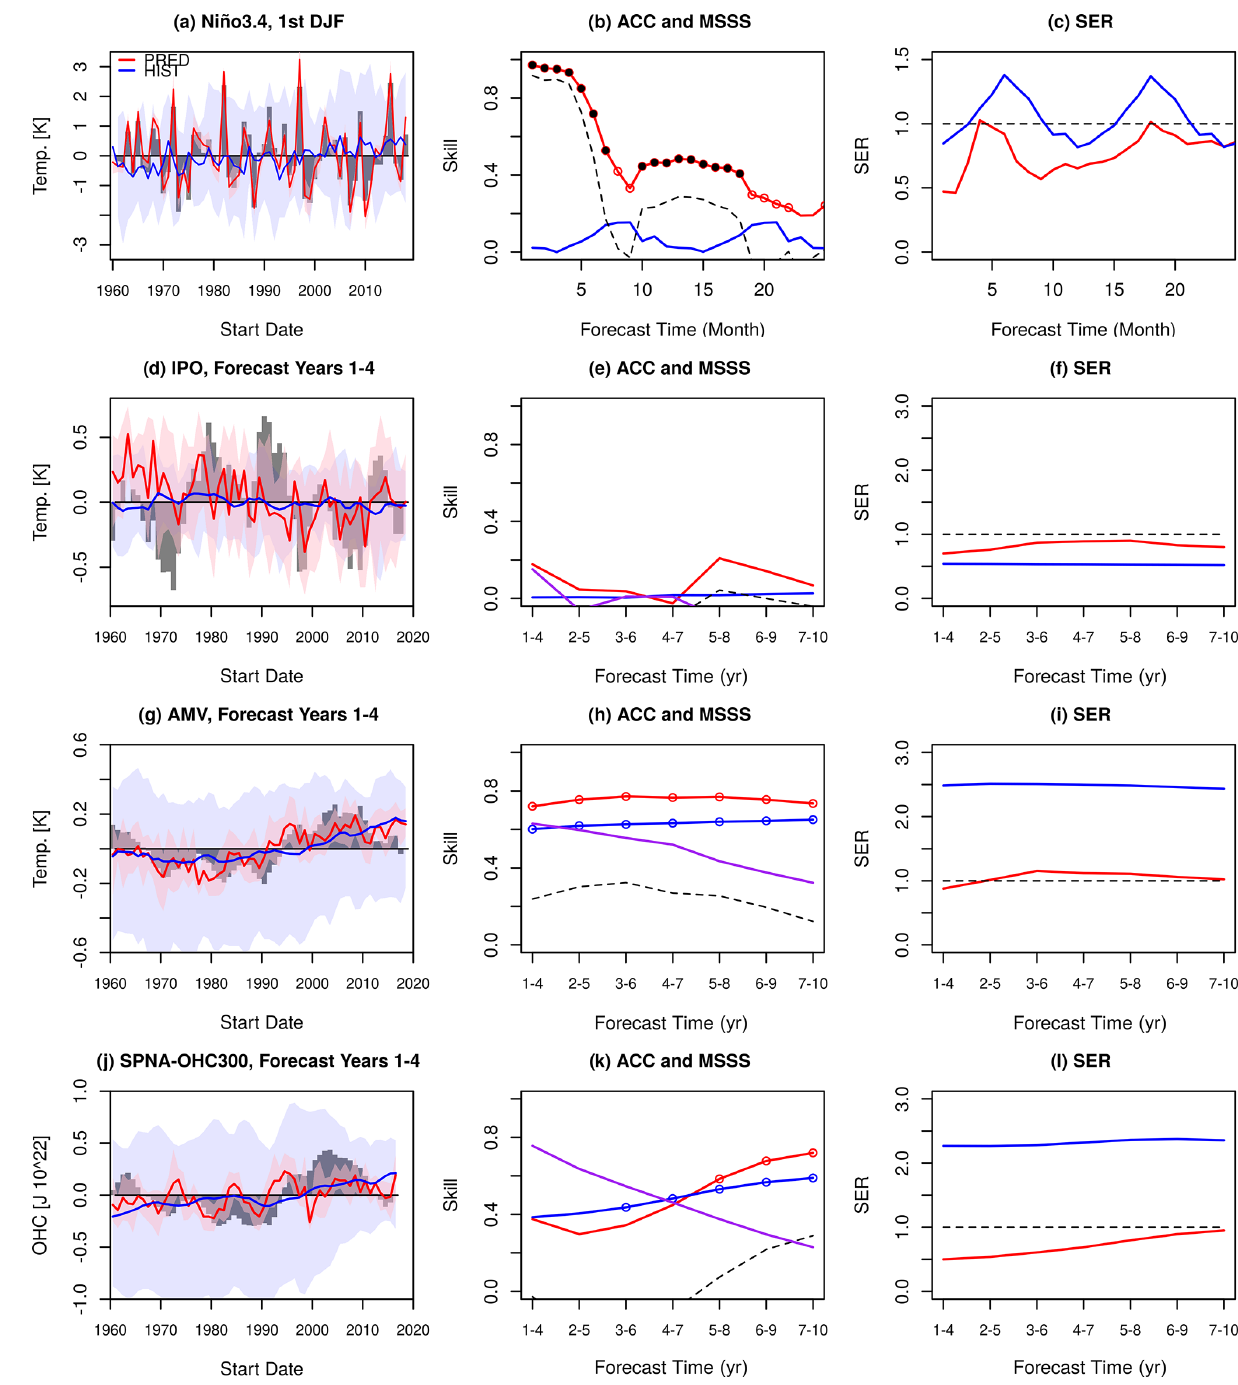
Figure 5. Skill of the selected modes of ocean variability: (a–c) ENSO (Niño3.4 index), (d–f) IPO, (g–i) AMV and (j–l) SPNA-OHC300. Panels (a) , (d) , (g) and (j) show the observed (grey bars) and predicted (PRED in red and HIST in blue) time series of the indices. The ensemble means are represented using lines, and the ensemble spread is shown using coloured shading. Panel (a) shows the ENSO index for the first winter (DJF), whereas panels (d) , (g) and (j) show the average of the first 4 forecast years for the other indices. Panels (b) , (e) , (h) and (k) show the ACC of PRED (red) and HIST (blue), the MSSS of PRED considering HIST the baseline prediction (black dashed line) and the ACC of a persistence forecast (purple). Statistically significant ACC values (at the 95% confidence level) are shown using empty circles. ACC differences that are statistically significant (at the 95% confidence level) between the PRED and HIST are shown using filled circles. Panels (c) , (f) , (i) and (l) show the spread–error ratio of PRED (red) and HIST